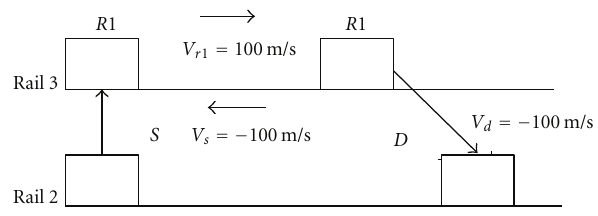
Figure 2: Communication model of Case